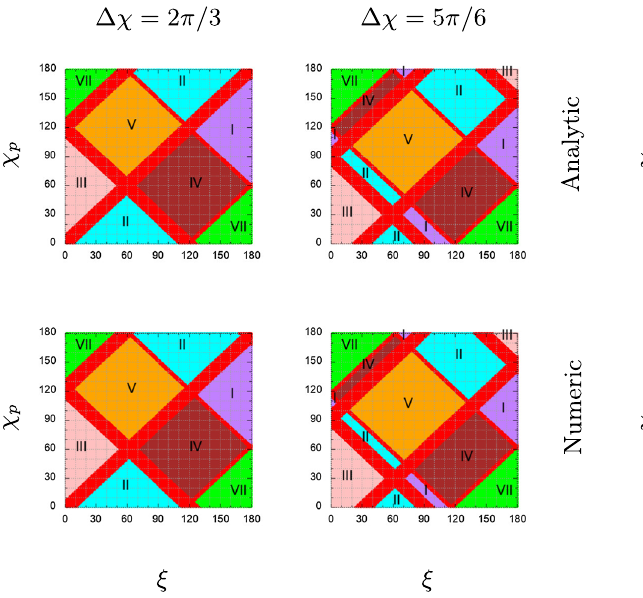
Fig. 21 Class location maps on the ξ − χ p plane. RN-like metric, (cid:11) = 0 . 3, q ∗ = − ( 0 . 50 M ) 2